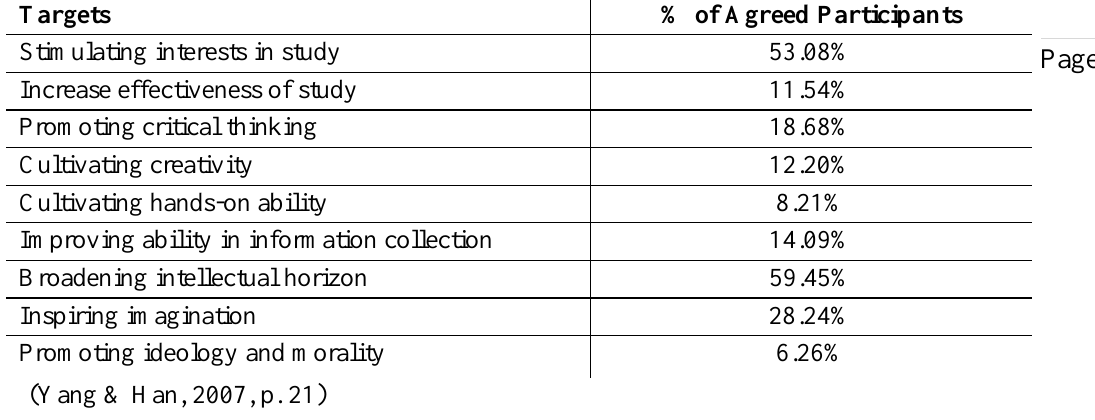
Fostering Student Development: 13 Provinces